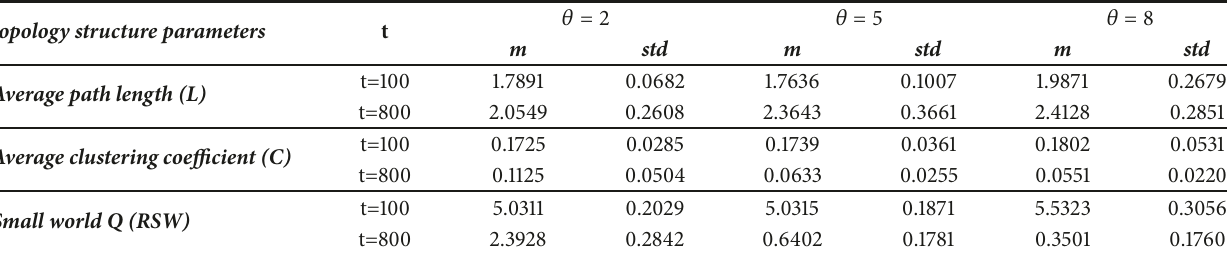
Table 1: The network topology parameters under different 𝜃 values at 𝑡 = 100 and 𝑡 = 800 . topology structure parameters